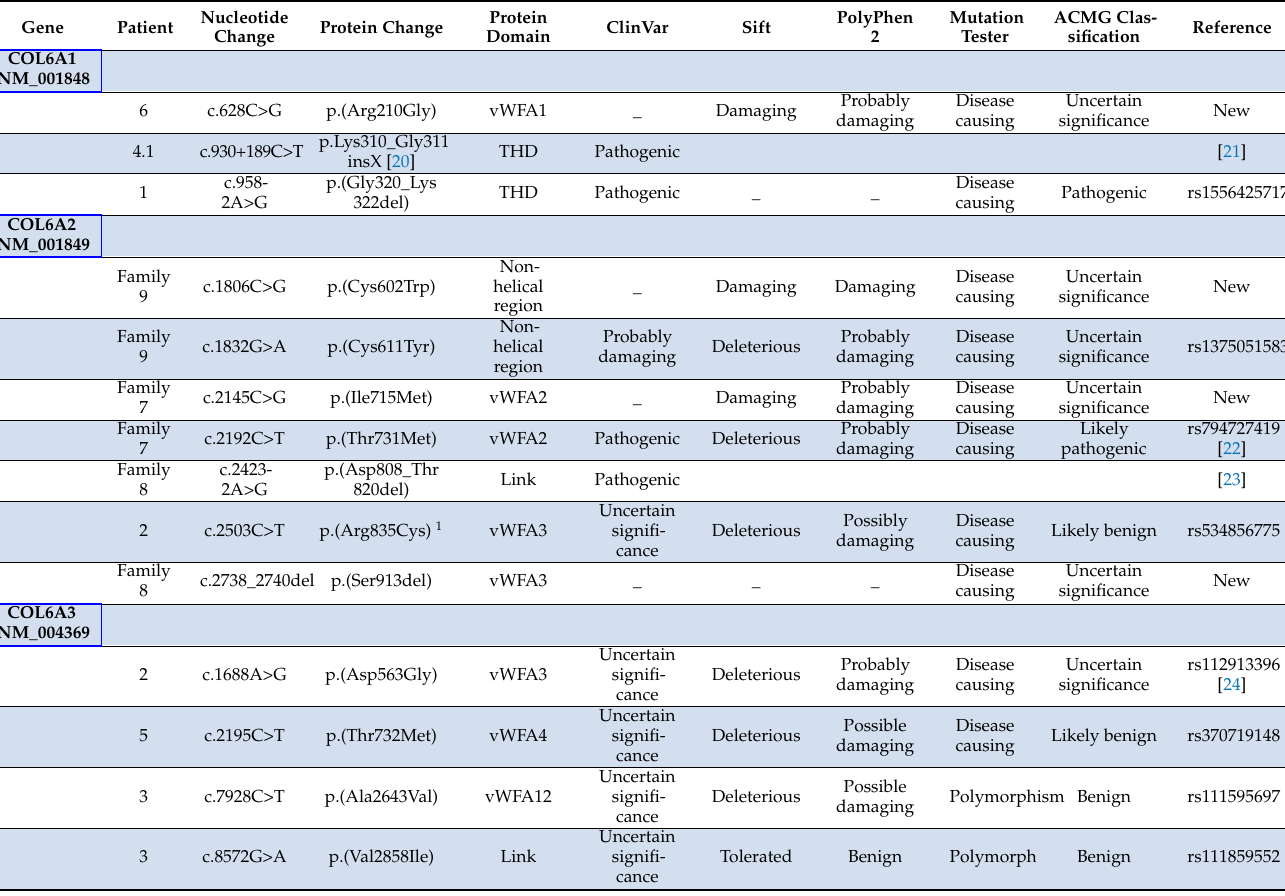
Table 2. Genetic variants of